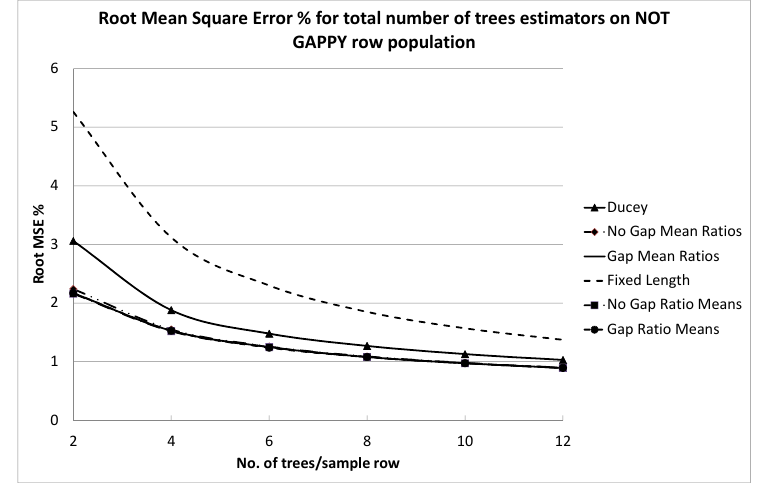
Figure 7. Root mean square error percentages for the NOT GAPPY row population for the total number of trees estimated by Ducey’s estimator, ¯ˆ Y D , shown in Equation (7); the “No Gap Mean Ratios” estimator, ˆ Y NG − MR , shown in Equation (17); the “Gap Mean Ratios” estimator, ˆ Y G − MR , shown in Equation (12); the “No Gap Ratio Means” estimator, ˆ Y NG − RM , shown in Equation (11); the “Gap Ratio Means” estimator, ˆ Y G − RM , shown in Equation (10); and fixed length row sampling for 10 random sample locations and numbers of trees per sample, ranging from two to